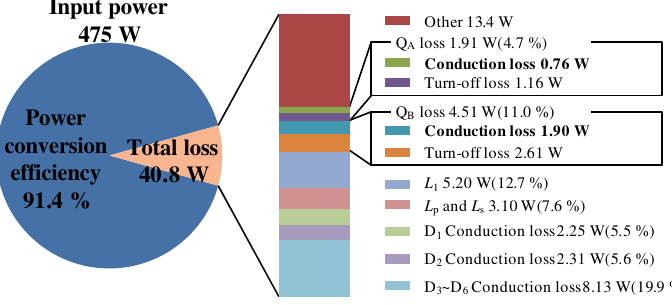
Figure 26. Loss analysis of the LED driver using SiC MOSFET DC-DC converters.